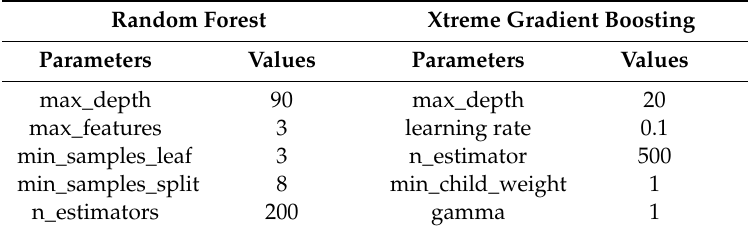
Table 5. Optimum parameters.